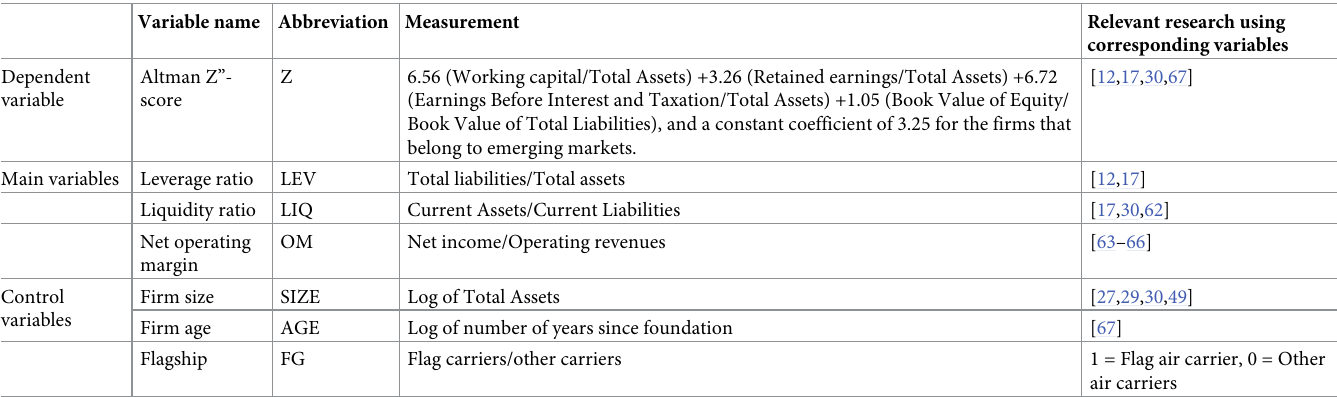
Table 1. Summary of variables and measurement.